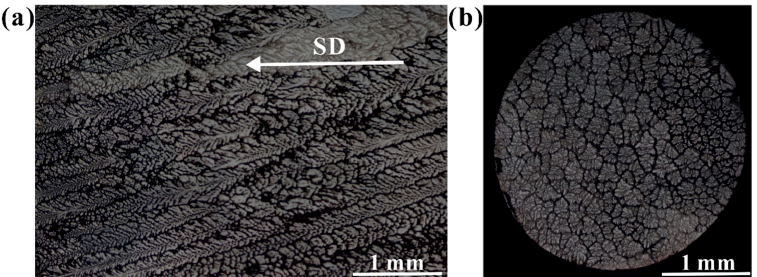
Figure 1. Microstructure of stable growth region of Ni–Mn–Sn crystal: ( a ) Longitudinal section. ( b ) Cross-section.